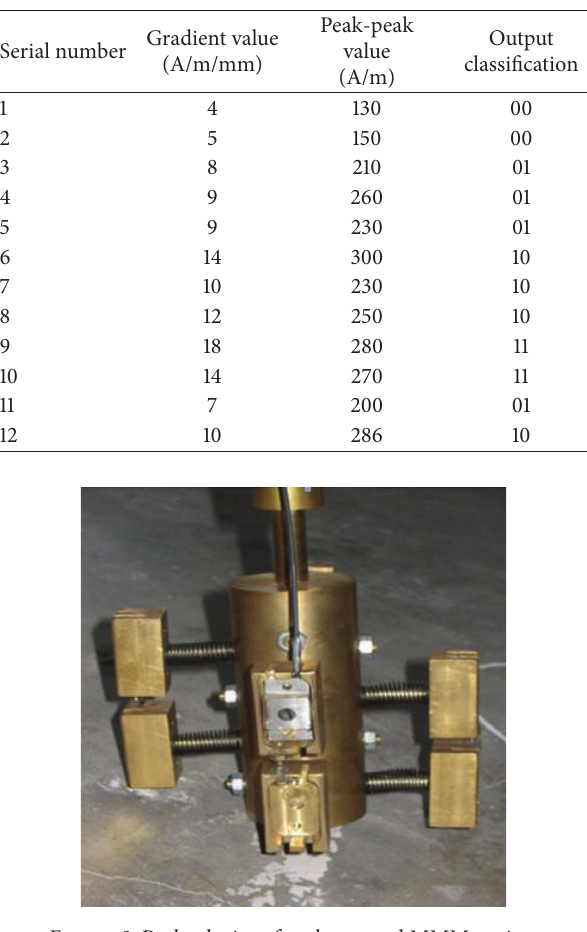
Figure 9: Probe device of underground MMM